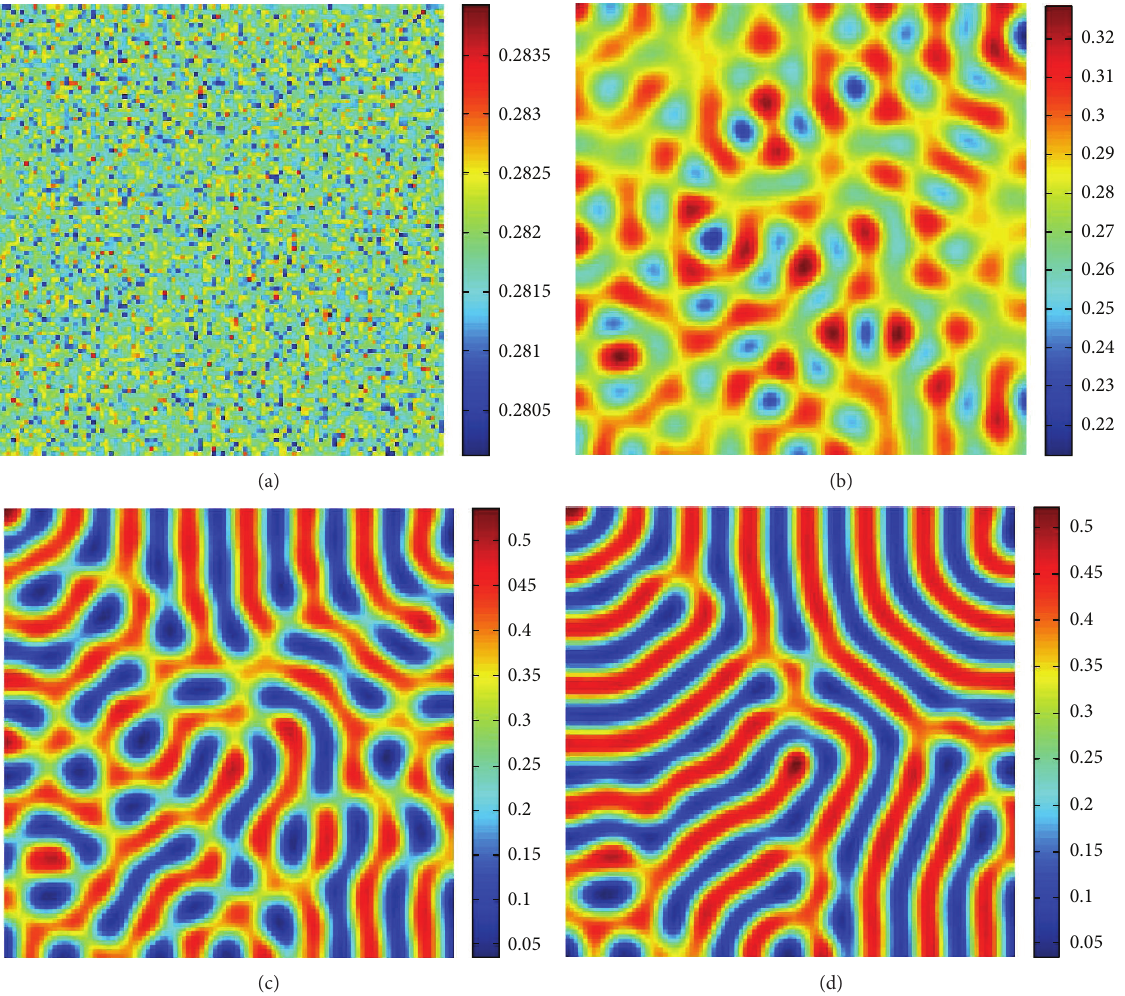
Figure 2: Typical Turing patterns of 𝑢 in model (7) with parameters 𝛼 = 1 , 𝛽 = 0.3 , 𝛾 = 0.3 , 𝑏 = 0.5 , 𝑐 = 0.6 , 𝑚 = 0.6 , 𝑞 = 0.35 , 𝑠 = 2 , = 0.015 , and 𝑑 = 1 . Times: (a) 0; (b) 50; (c) 250; (d) 𝑑 1 2